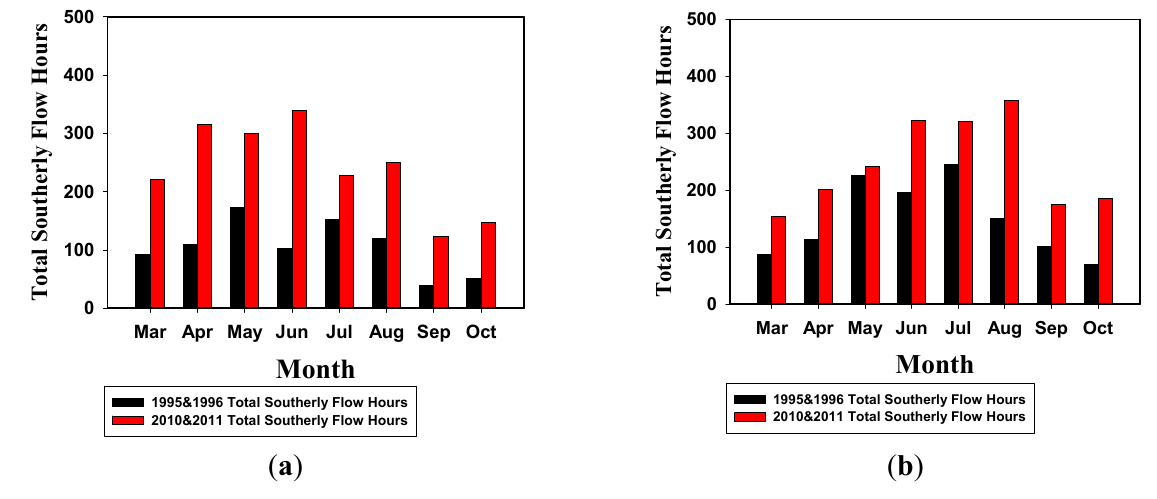
Figure 5. Total southerly flow average hours in 1995–1996 (black) and 2010–2011 (red) at Aldine ( a ) and Galveston ( b